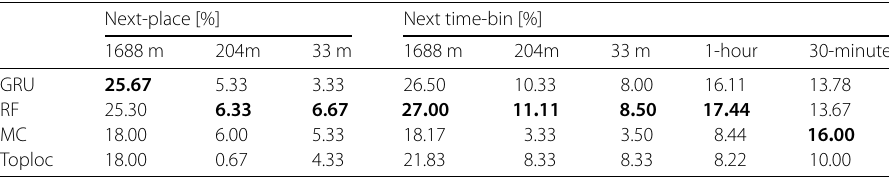
Table 4 A relative number of cases when prediction accuracy of four different prediction algorithms surpasses the predictability limit calculated for the two types of mobility sequences of various spatio-temporal resolution Next-place [%] Next time-bin [%]